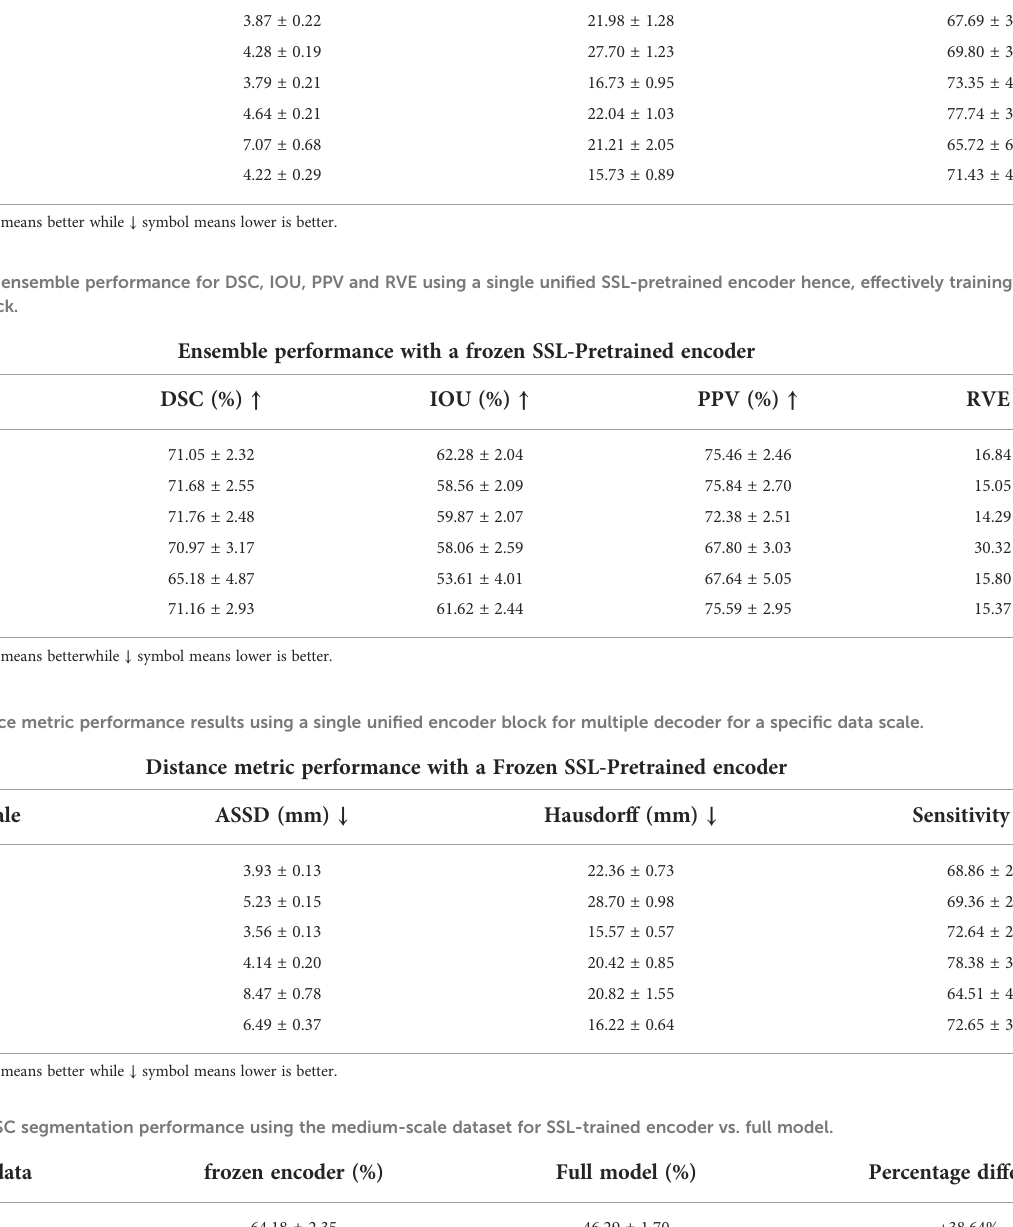
TABLE 6 Distance metric results of the model ensemble for each data scale highlighting the effectiveness of the model ensemble. Model ensemble performance with distance metric UNet-2.5D-Scale